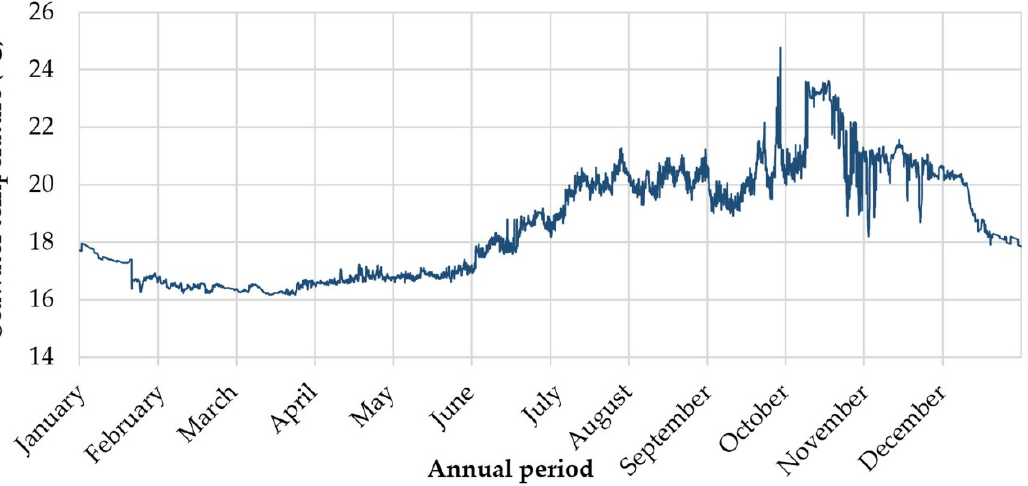
Figure 17. Annual fluctuation in the seawater temperature at a 50 m depth, 50 miles north from Heraklion city, Crete [93].